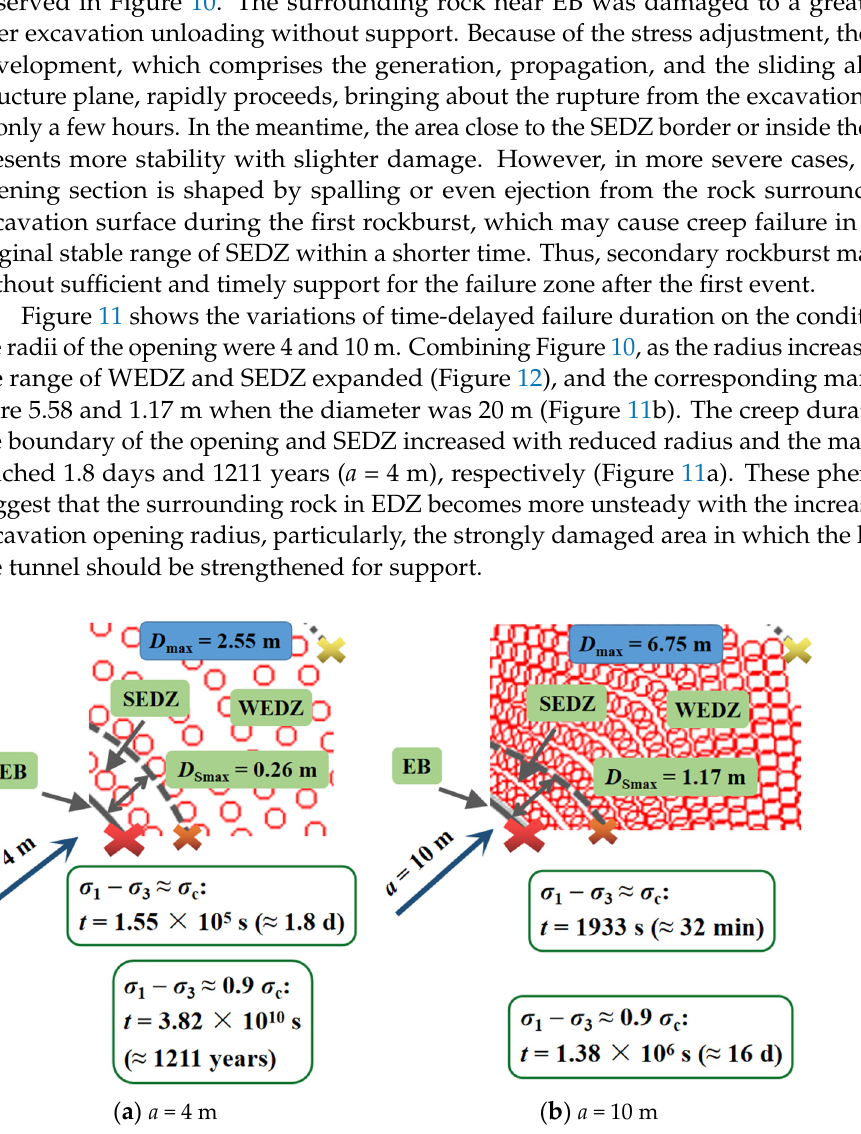
Figure 10. Time-delayed failure laws in EDZ for the round tunnel cross section at the depth of 1900 m ( a = 6.5 m).